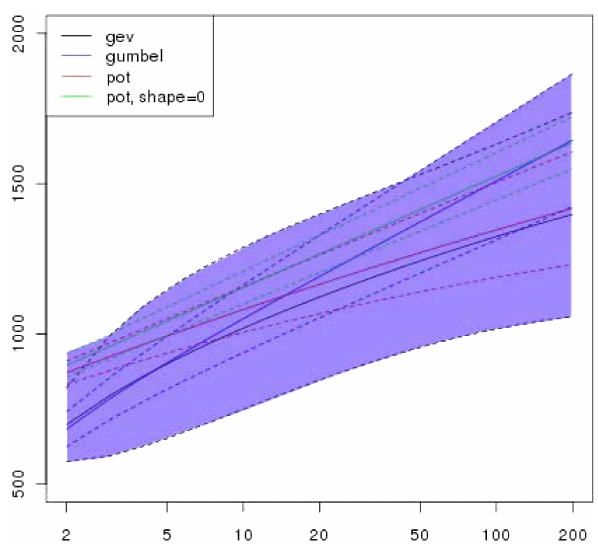
Figure 5. With 95% confidence, the hazard is located in the blue zone. Horizontal: return times. Vertical: estimated flow